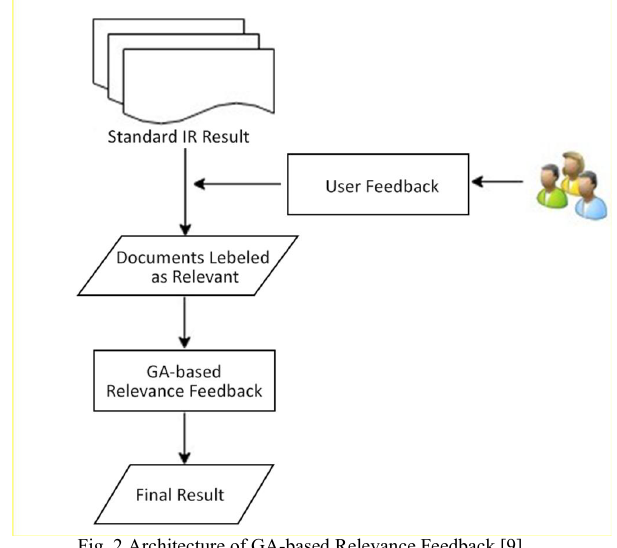
Fig. 2 Architecture of GA-based Relevance Feedback